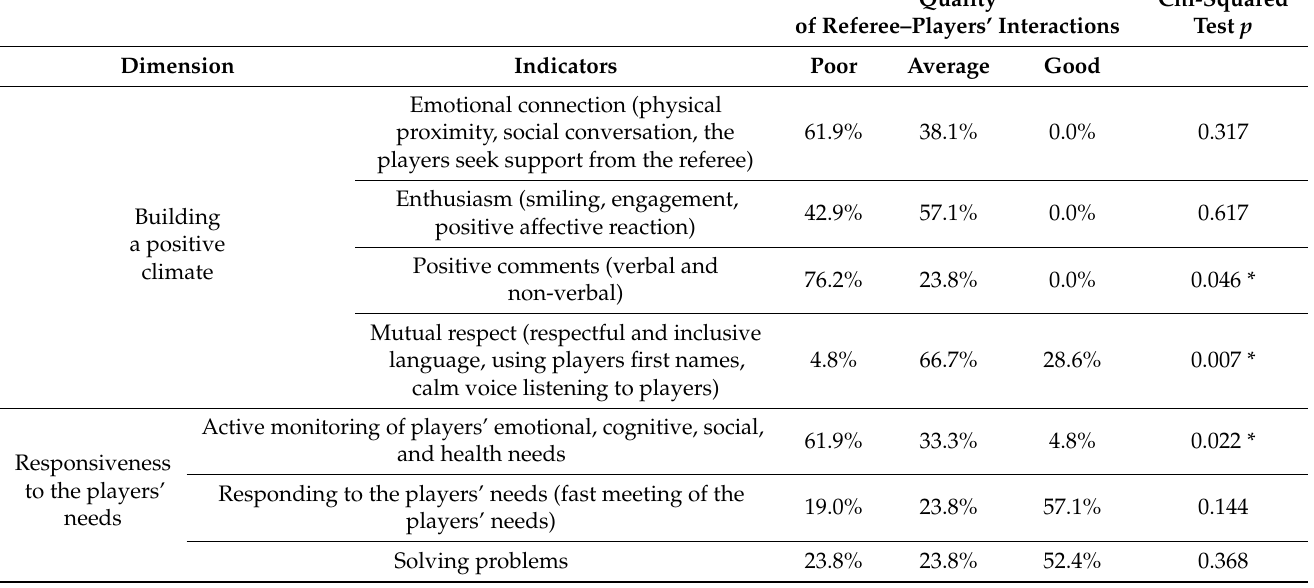
Table 6. Assessment the quality of referee–players’ interactions in the dimension of building a positive climate and responsiveness to players’ needs during children’s floorball competitions ( n = 21). Quality Chi-Squared of Referee–Players’ Interactions Test p Dimension Indicators Poor Average